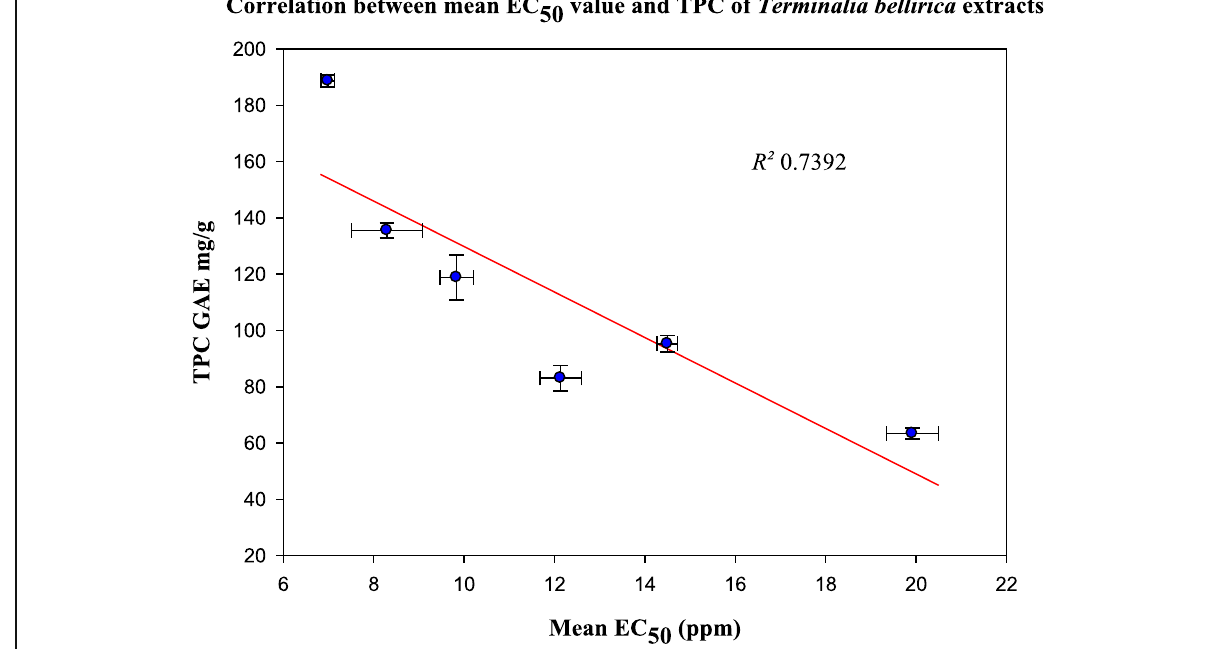
Fig. 6 Relationship between total phenolic content (TPC in gallic acid equivalents, GAE) and EC 50 values of DPPH scavenging